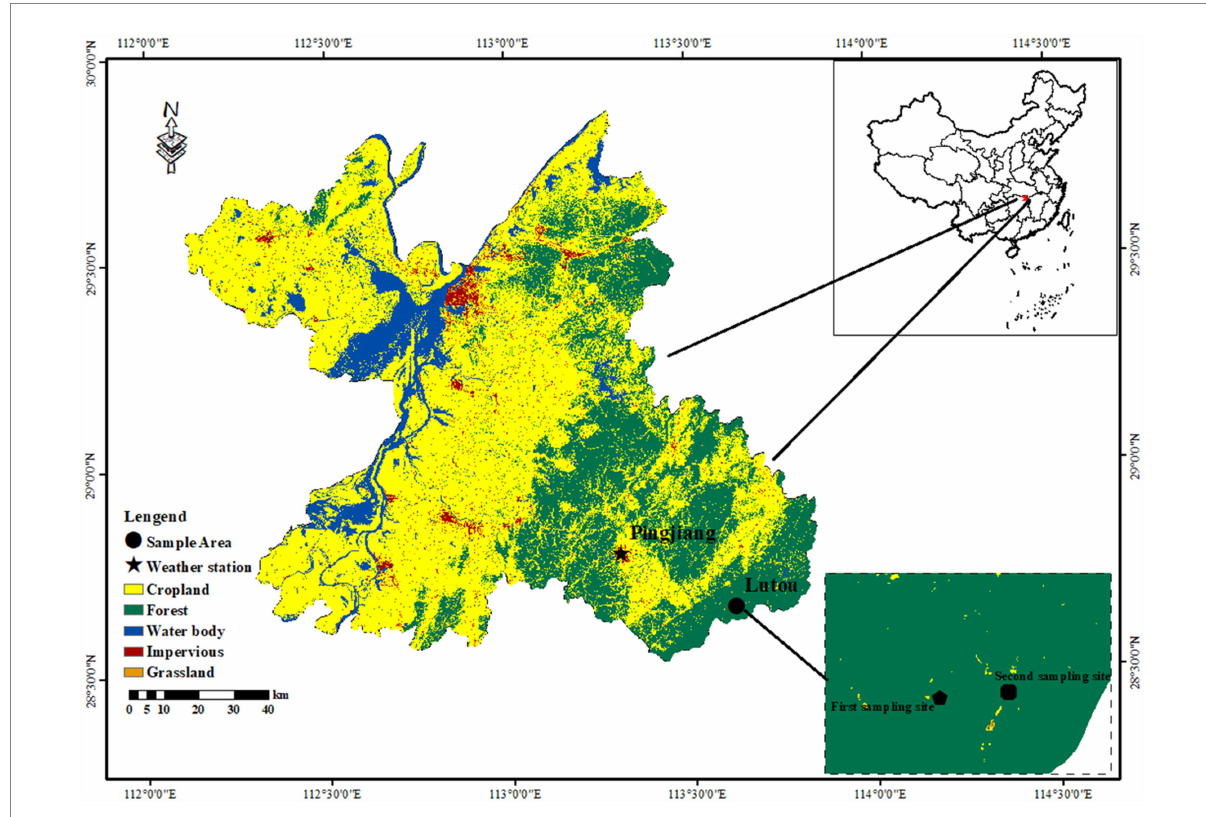
FIGURE 1 Location of the study area (Lutou) and weather station (Pingjiang) in the northern Luoxiao Mountain. Samples were collected at the first sampling site in September 2020 and at the second sampling site in July